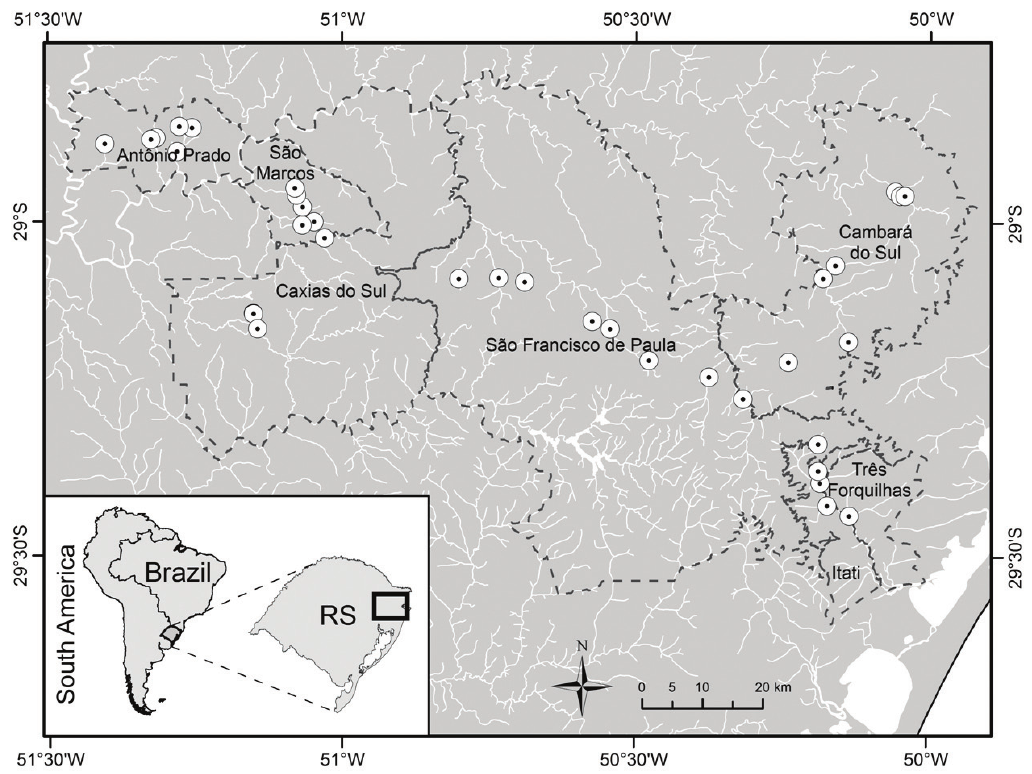
Figure 1. Sampling sites distribution in the northeast region of Rio Grande do Sul,